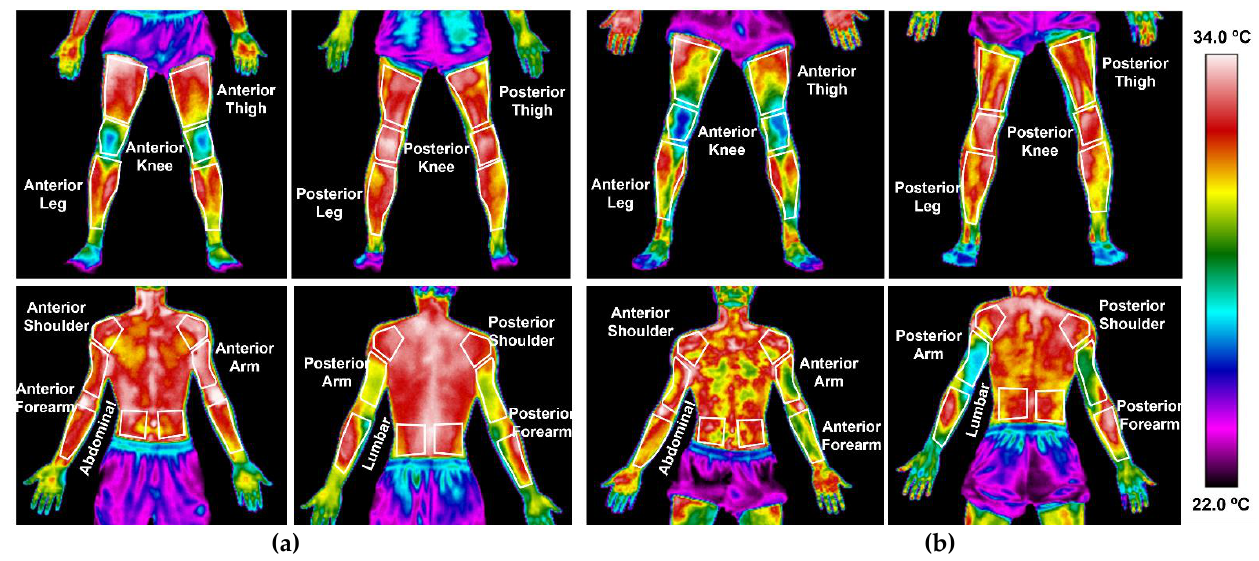
Figure 3. Example of the infrared thermography images taken of the athletes with their respective upper and lower limb regions of interest: ( a ) participant 4 pre-training images; ( b ) participant 4 post-training images.